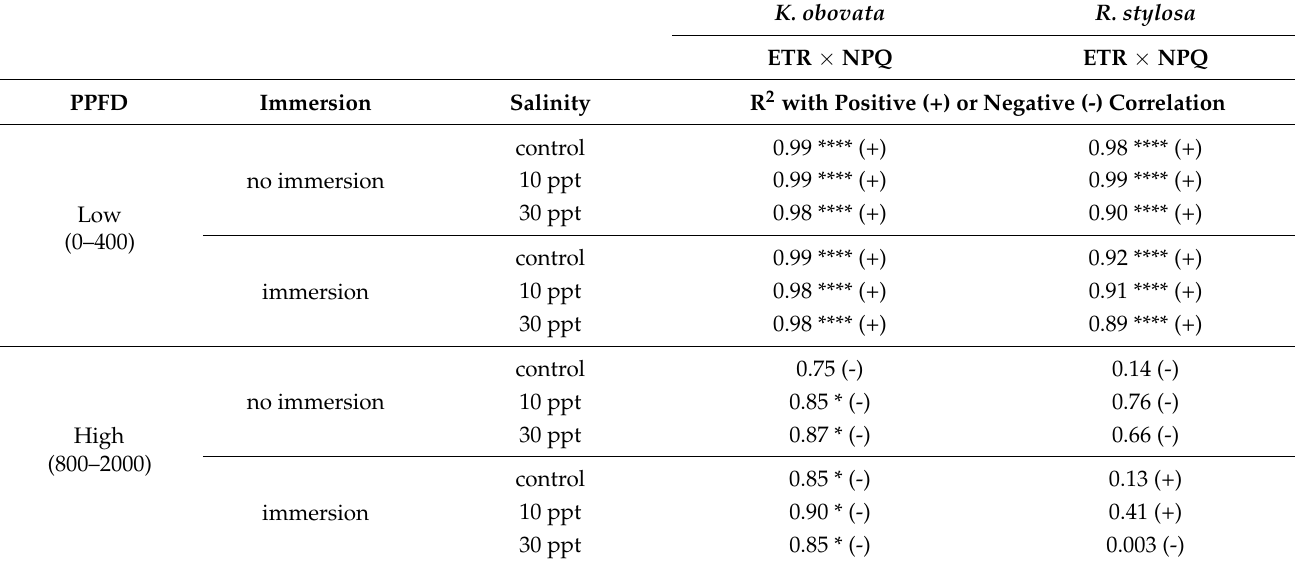
Table 1. The relationship between ETR and NPQ of K. obovata and R. stylosa cultivated under 0, 10, and 30 ppt salinity treatments with and without immersion conditions. Measurements were recorded at 25 ◦ C with PPFD at 0–400 (low) and 800–2000 (high) µ mol photon · m − 2 · s − 1 . Each symbol represents the average of 5 seedlings randomly selected from each treatment under 0, 5, 10, 15, 25, 50, 75, 100, 200, 400, 800, 1200, 1500, 1800, and 2000 PPFD luminosity changes, and a total of 5–10 values were used for each linear regression analysis.